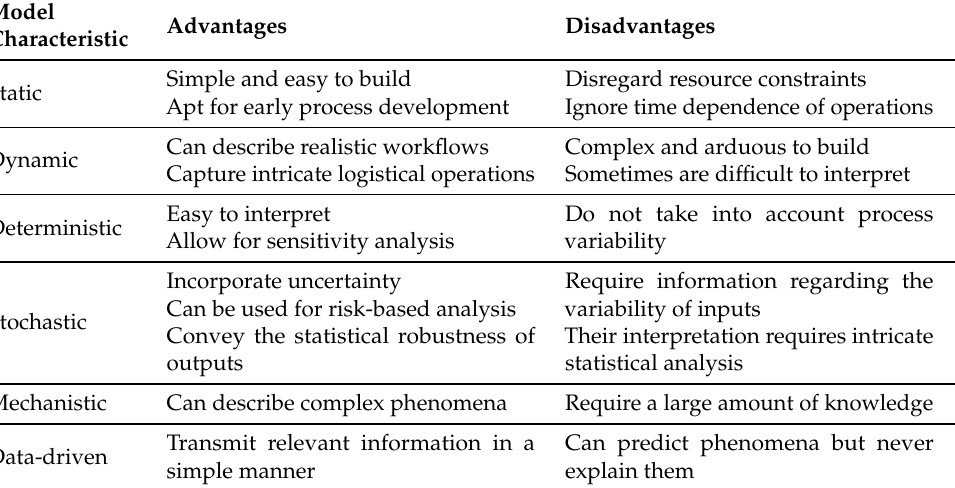
Table 1. Summary of the advantages and disadvantages of bioprocess model